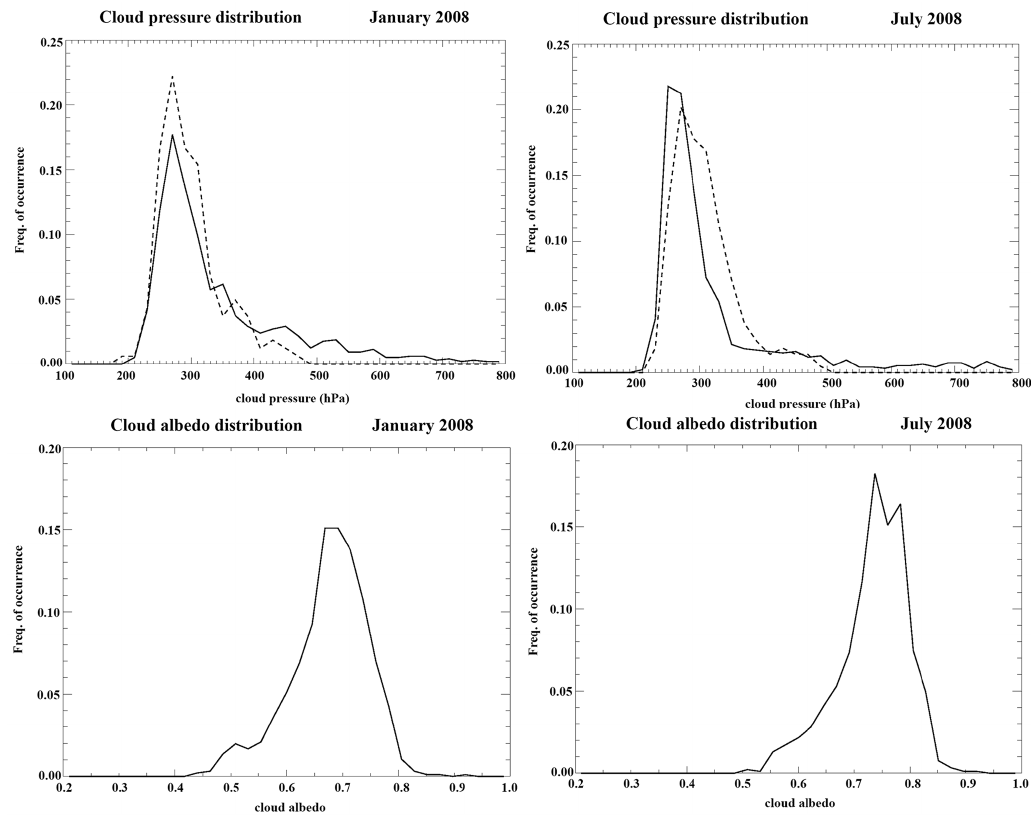
Figure 2. Histograms of ROCINN cloud pressures (top) and cloud albedos (bottom) for the area 12.5 ◦ S–12.5 ◦ N / 70 ◦ E–170 ◦ W. Cloud top pressure from ISCCP-D2 has been plotted as well (dashed line). The ROCINN and ISCCP cloud data have been spatially averaged on a 2.5 ◦ latitude by 2.5 ◦ longitude grid, and then the relative number of grid cells has been plotted as a function of cloud pressure and cloud albedo. Results are shown for (left) January 2008 and (right) July 2008. ROCINN and ISCCP-D2 cloud pressure distributions are in good agreement (see Sect. 3.3 for an explanation of the